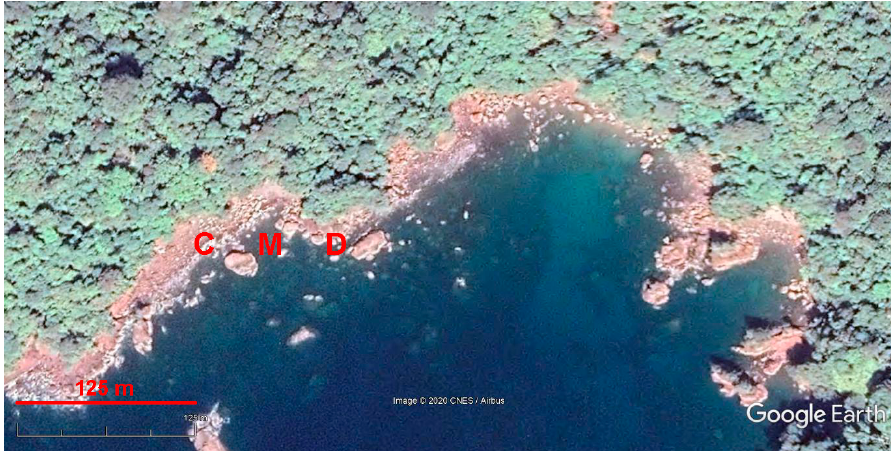
Figure 9. The northern plot of the Humboldt o Coredo Bay locality (the view provided by the Google Earth Engine).